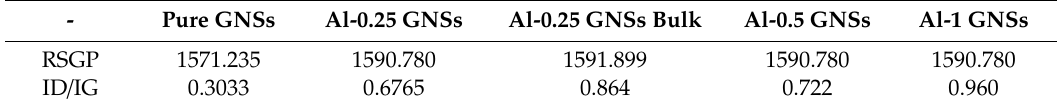
Table 1. Summary of information related to the Raman